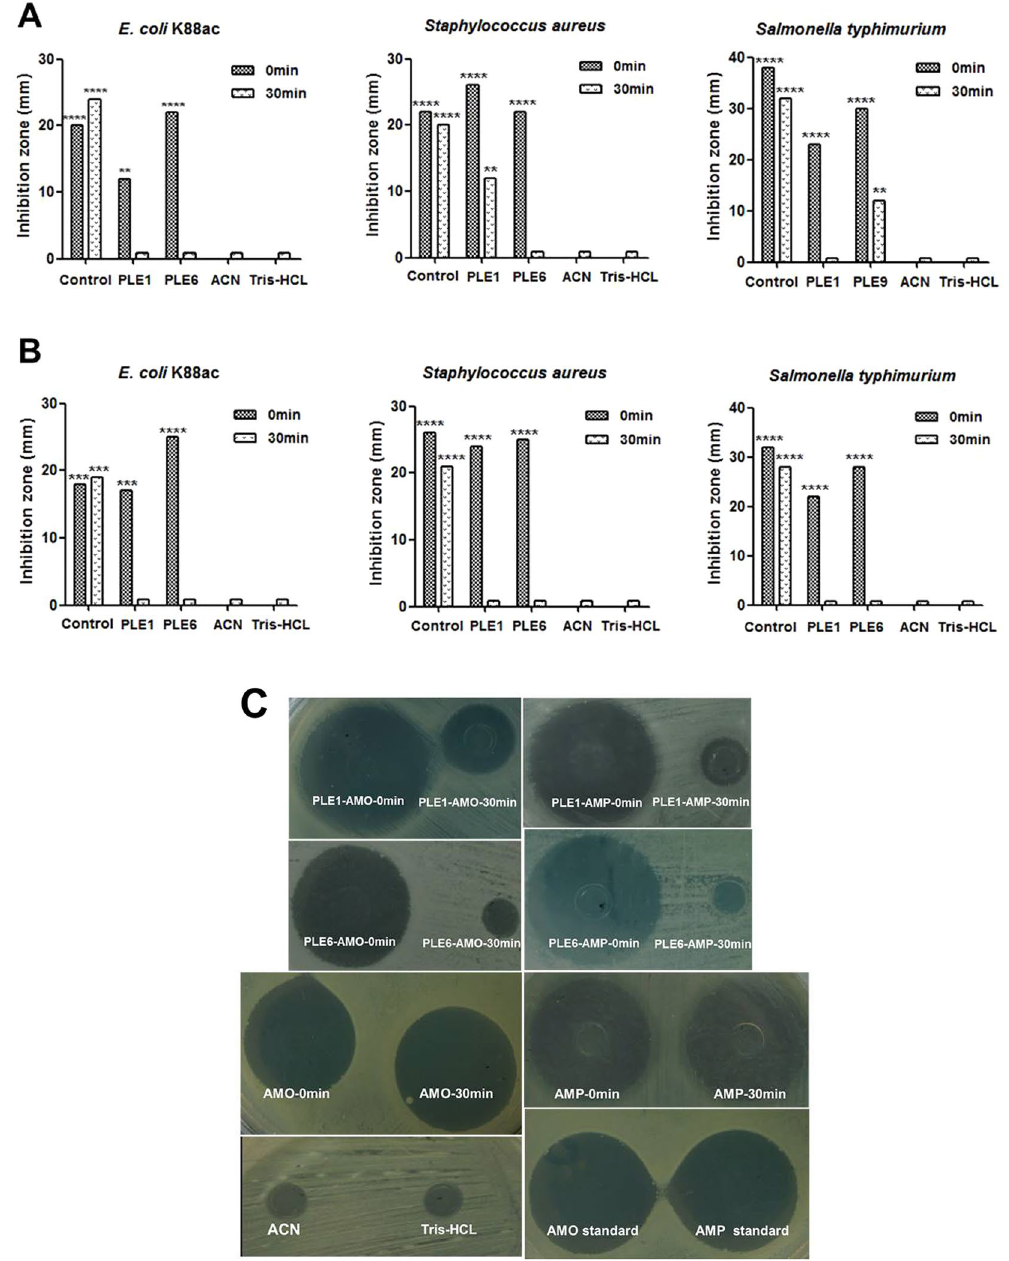
Figure 5. Antibacterial activities of AMO, AMP or metabolites hydrolyzed by PLEs. ( A ) The antibacterial activity of AMO or products AMA hydrolyzed by PLE1 or PLE6. ( B ) The antibacterial activity of AMP or products APA hydrolyzed by PLE1 or PLE6. ( C ) The partially inhibition zone diagrams of AMO, AMP or metabolites hydrolyzed by PLEs for Salmonella typhimurium . The antibacterial activities of parent or daughter drugs were showed by diameter of inhibition zones. The diameter of inhibition zone > 20 mm is extremely sensitive showed by **** , 15–20 mm is highly sensitive showed by *** , 10–15 mm is moderately sensitive showed by ** , < 10 mm is slightly sensitive, ≤ 0 mm is